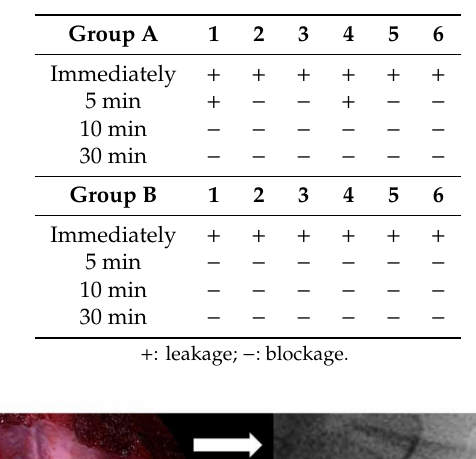
Table 1. Comparison of chylous leakage by time zone in groups A and B.